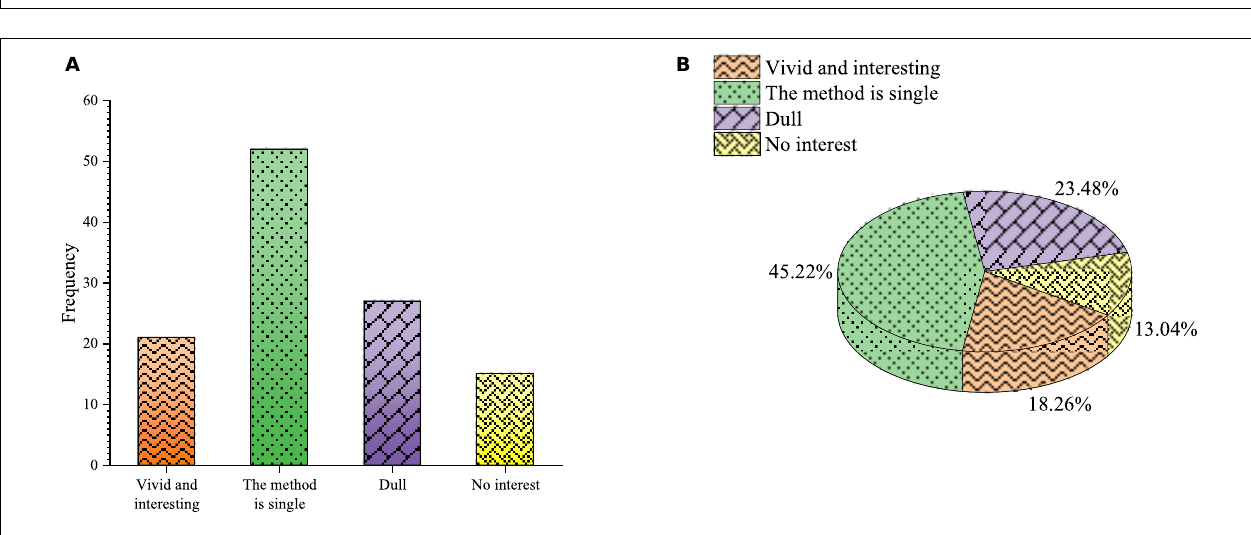
FIGURE 11 | Teachers for entrepreneurship education (A) frequency (B) percentage.